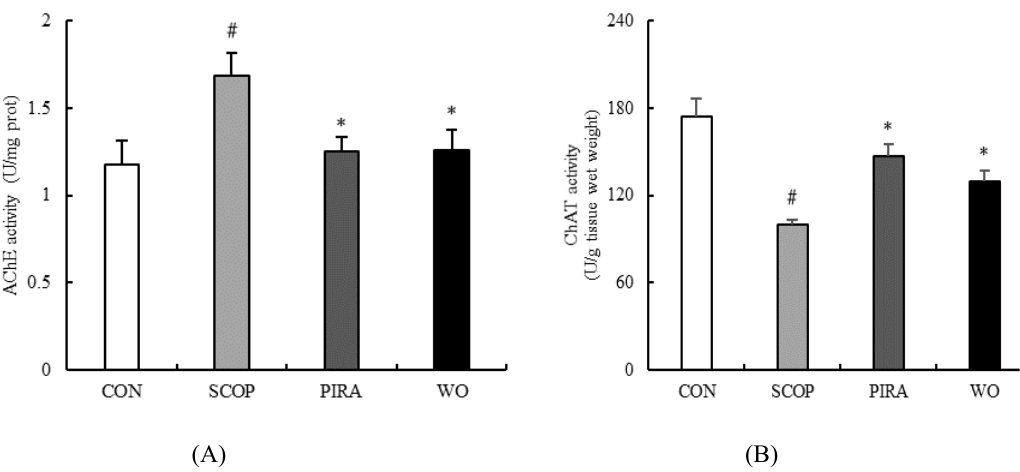
Figure 2. E ff ects of walnut oil on the activity of AChE ( A ) and ChAT ( B ) in brains of mice. Data are shown as mean ± SEM. # p < 0.05 versus the control group. * p < 0.05 versus the SCOP-treated